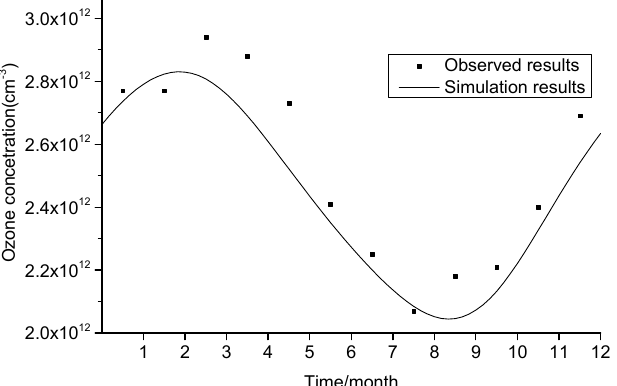
Figure 3. Model simulation and satellite observation of ozone variation at 18 km altitude over the Pacific Ocean (25–40° N, 140–180° E) (The scattered points are the observation results, and the solid line shows the simulation results).